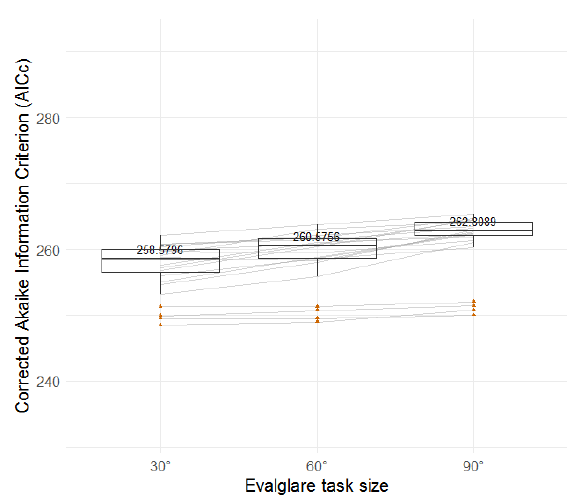
Figure 27. Boxplots of AUC for the three task area sizes (laboratory study).